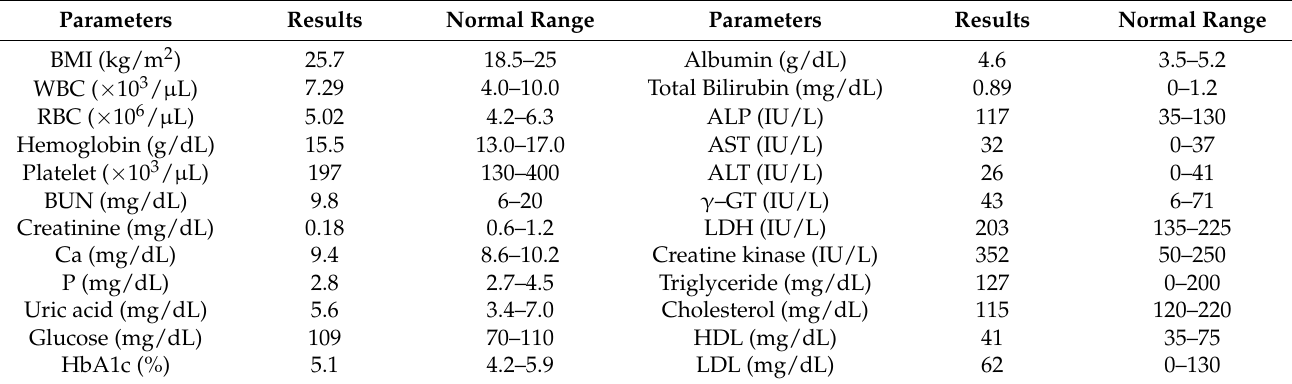
Table 1. The patient’s clinical and laboratory